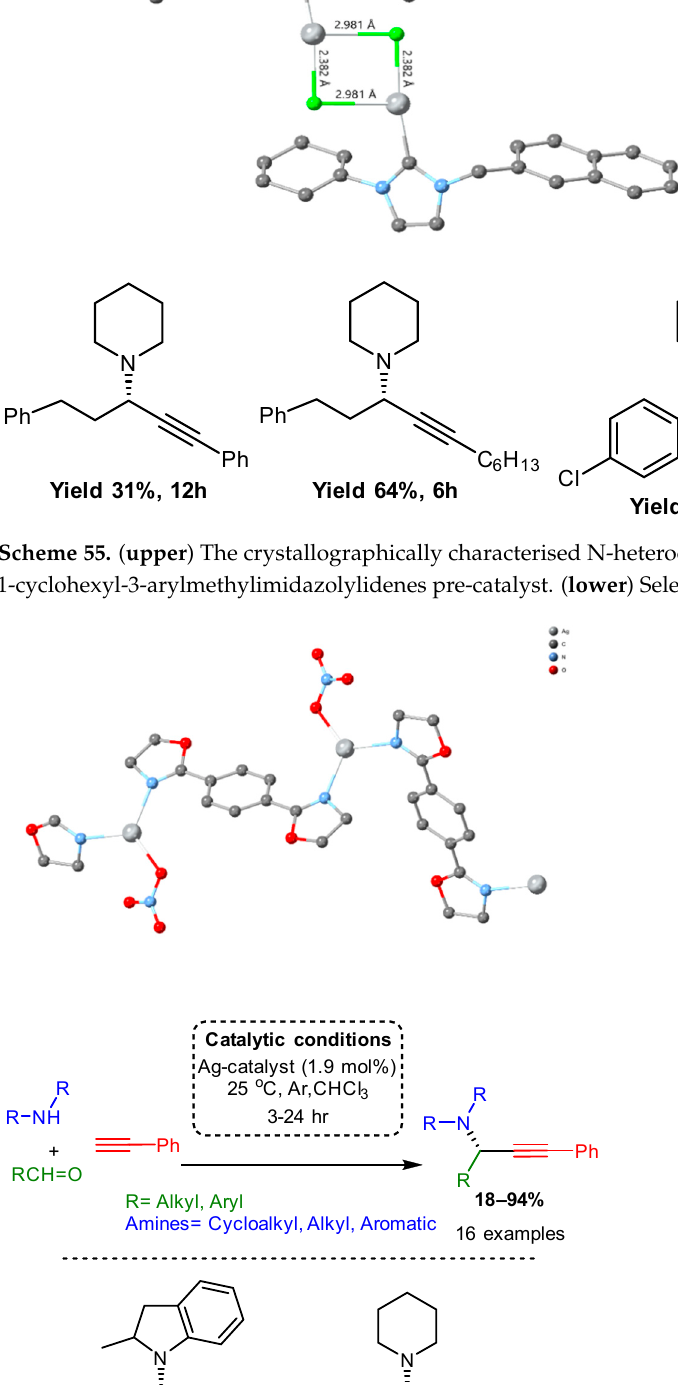
R= Alkyl, Aryl Amines= Cycloalkyl, Alkyl, Aromatic